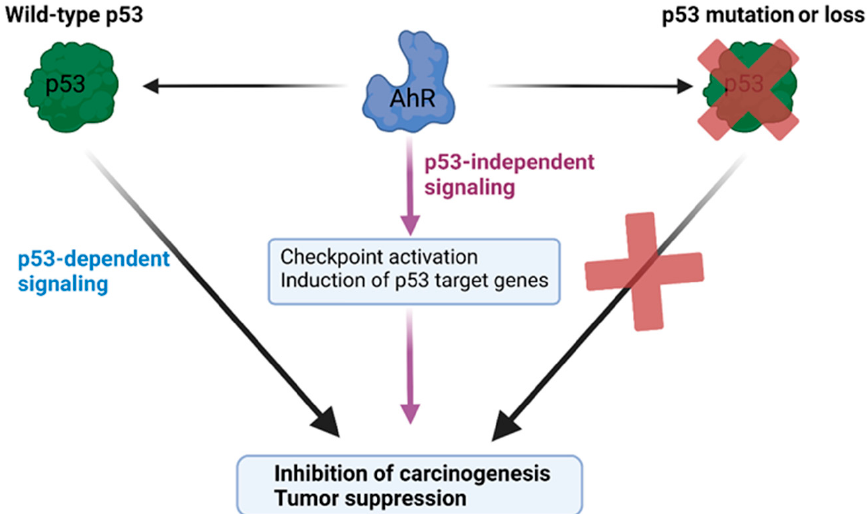
Figure 5. Model of the cooperative roles of AhR and p53 in tumor suppression. The diagram depicts a model of p53 and AhR cooperating in restraining carcinogenesis. AhR exerts both p53-dependent and p53-independent tumor-suppressive activities. The activation of AhR can promote p53-dependent antiproliferative effects, and, in the absence of wild-type p53 activity, the expression of AhR is protective against carcinogenesis and exerts tumor suppression via p53-independent gene